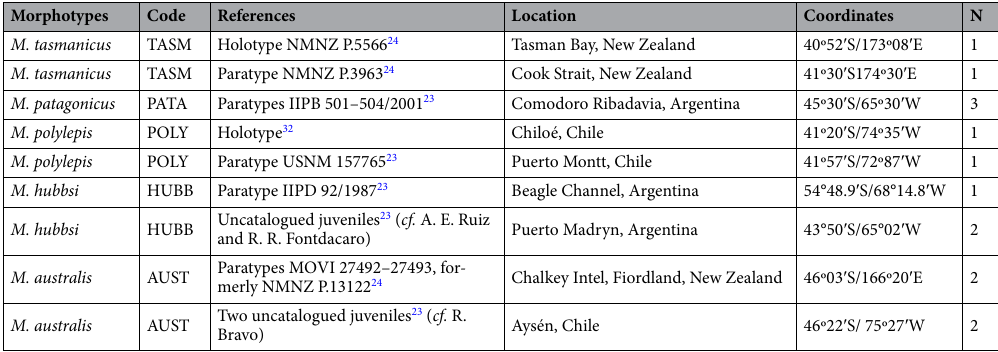
Table 2. Origin of rare hake morphotypes from directed sampling campaigns and museum holotypes and paratypes used in the molecular phylodiagnosis. N is the number of specimens analyzed per morphotype (see also Supp. Table